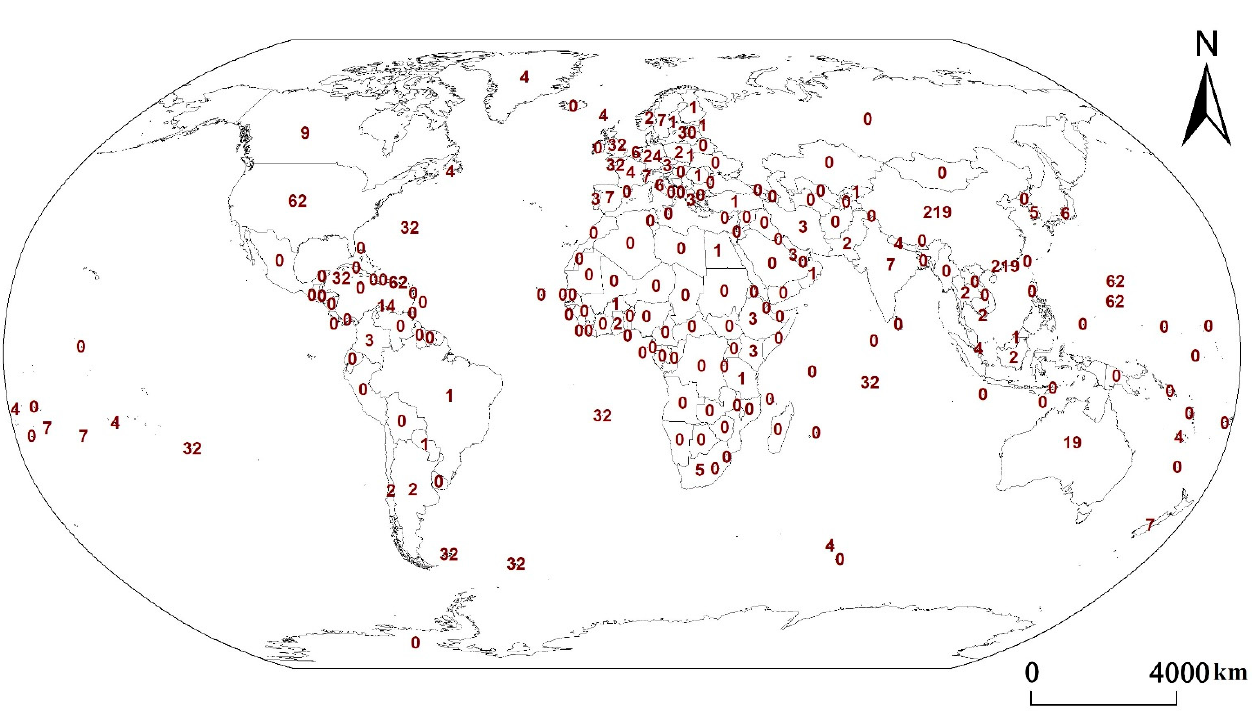
Figure 9. Trade-off studies at different scales. 4.2. China’s Perspective The topics of “urbanization”, “ecosystem services”, “trade-offs”, and “China” were retrieved from the Web of Science Core Collection and CNKI database The number of